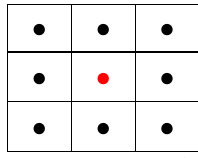
Figure 2. 8-neighbor